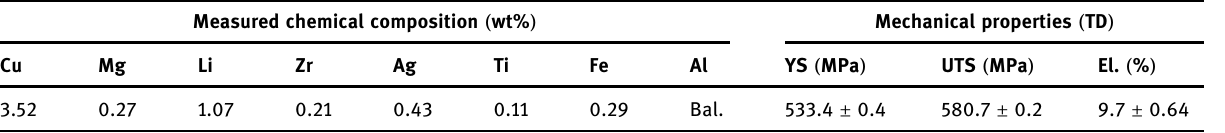
Table 1: Chemical compositions and mechanical properties of 2195 - T8 Al alloy Measured chemical composition ( wt%